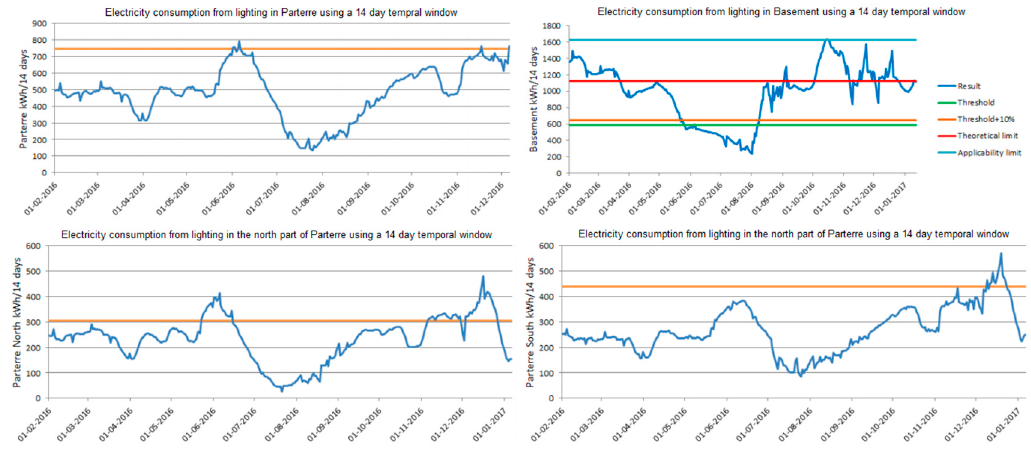
Figure 8. Plots of performance test results.